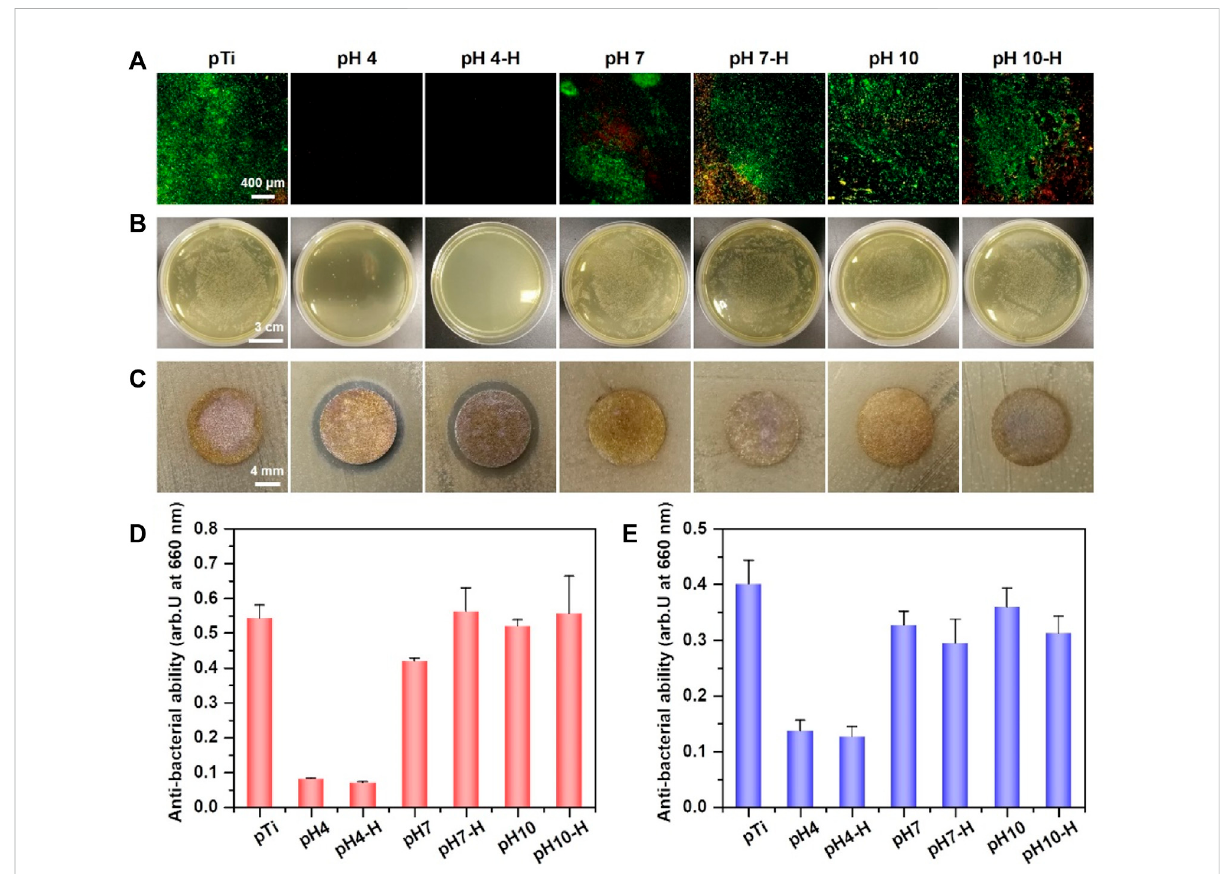
FIGURE 3 Assessment of antibacterial activity of different samples: (A) Live/Dead bacteria staining of S. aureus on different samples; (B) antibacterial property(S.aureus)ofvarioussamplesurfacesdeterminedbyspreadplatemethod; (C) thediameter ofinhibitionzonearoundvarioussamplesforS. aureus; (D) bacterial amount in the inoculum after incubation of various samples with S. aureus for 24 h by turbidimetric method; (E) bacterial amount in the inoculum of various samples after incubation with Aa for 24 h by turbidimetric